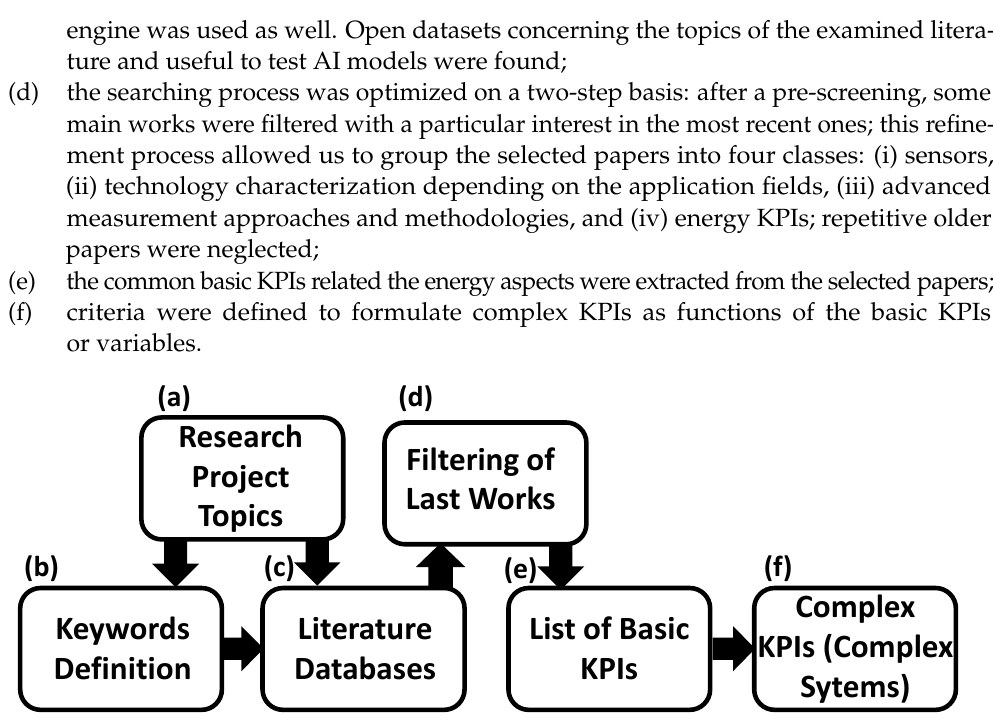
Figure 2. Diagram showing the methodology adopted for this study. The complex KPIs are important to model energy systems characterized by a large number of variables. If ( a , b , . . . ) are either significant basic KPIs or measured variables, a complex KPI can be expressed